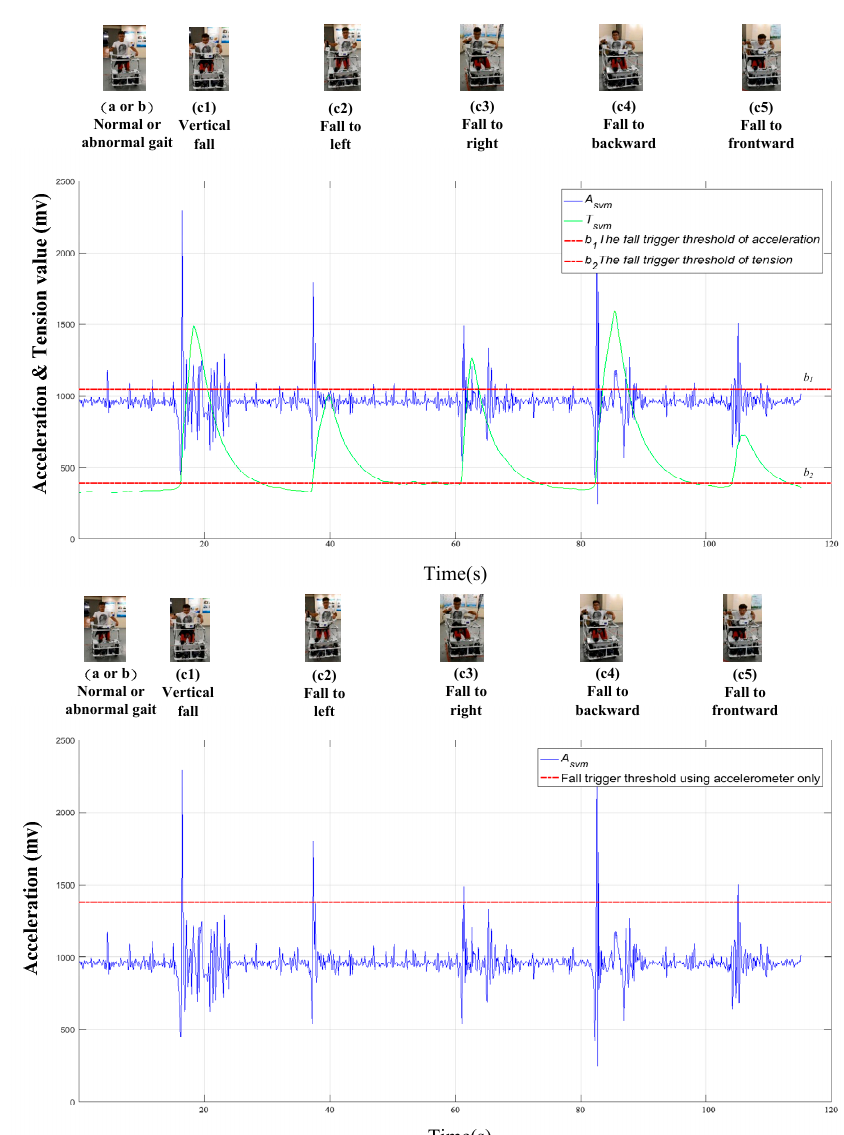
Figure 6. Threshold comparison between multisensor fusion and single-sensor